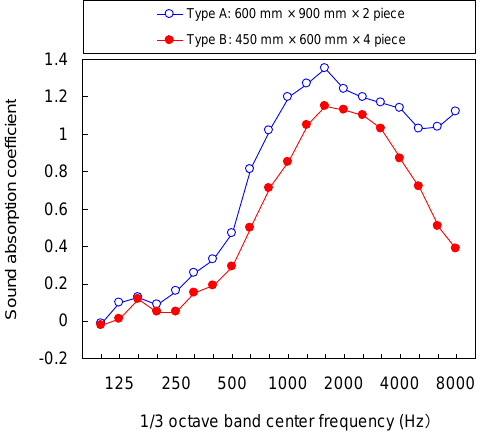
Figure 2. Sound absorption coefficient measurement results by JIS A 1409. Table 1. Type and size of the sound absorption panels used in the experiment.